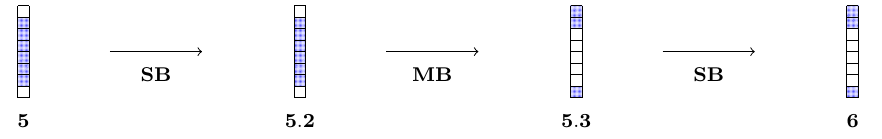
Figure 7: A truncated differential through a SuperSBox